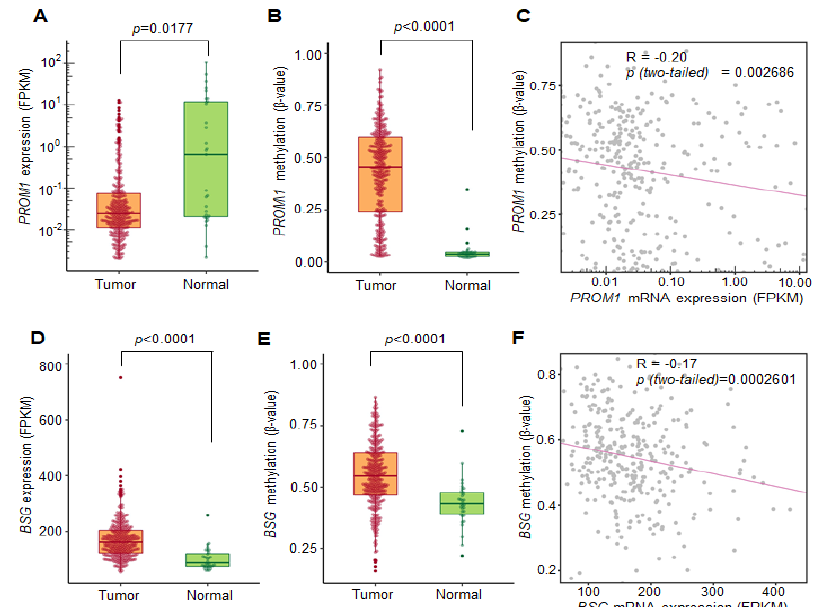
Figure 4. Correlation analysis between gene expression level and promoter methylation level from the TCGA database. ( A , D ) The expression levels of CD133 (PROM1) and CD147 (BSG) in tumor tissues were inversely correlated with the promoter DNA methylation rates. Expression levels of ( A ) CD133 and ( D ) CD147 in primary OSCC tumors ( n = 328) compared to normal oral mucosa ( n = 32), extracted from the TCGA HNSCC database. ( B , E ) The methylation levels of the CpG sites of ( B ) CD133 and ( E ) CD147 in primary OSCC tumors ( n = 338) compared to normal oral mucosa ( n = 34), extracted from the HNSCC TCGA database. ( C , F ) Negative correlation between the gene expression and promoter methylation of ( C , F ). Spearman’s correlation analysis was performed between the methylation (vertical axis) and gene expression (horizontal axis) of the CD133 ( R = − 0.20, p = 0.002686) and CD147 genes ( R = − 0.17, p = 0.0002601). The Spearman’s correlation coefficients and p -values are shown in each plot.